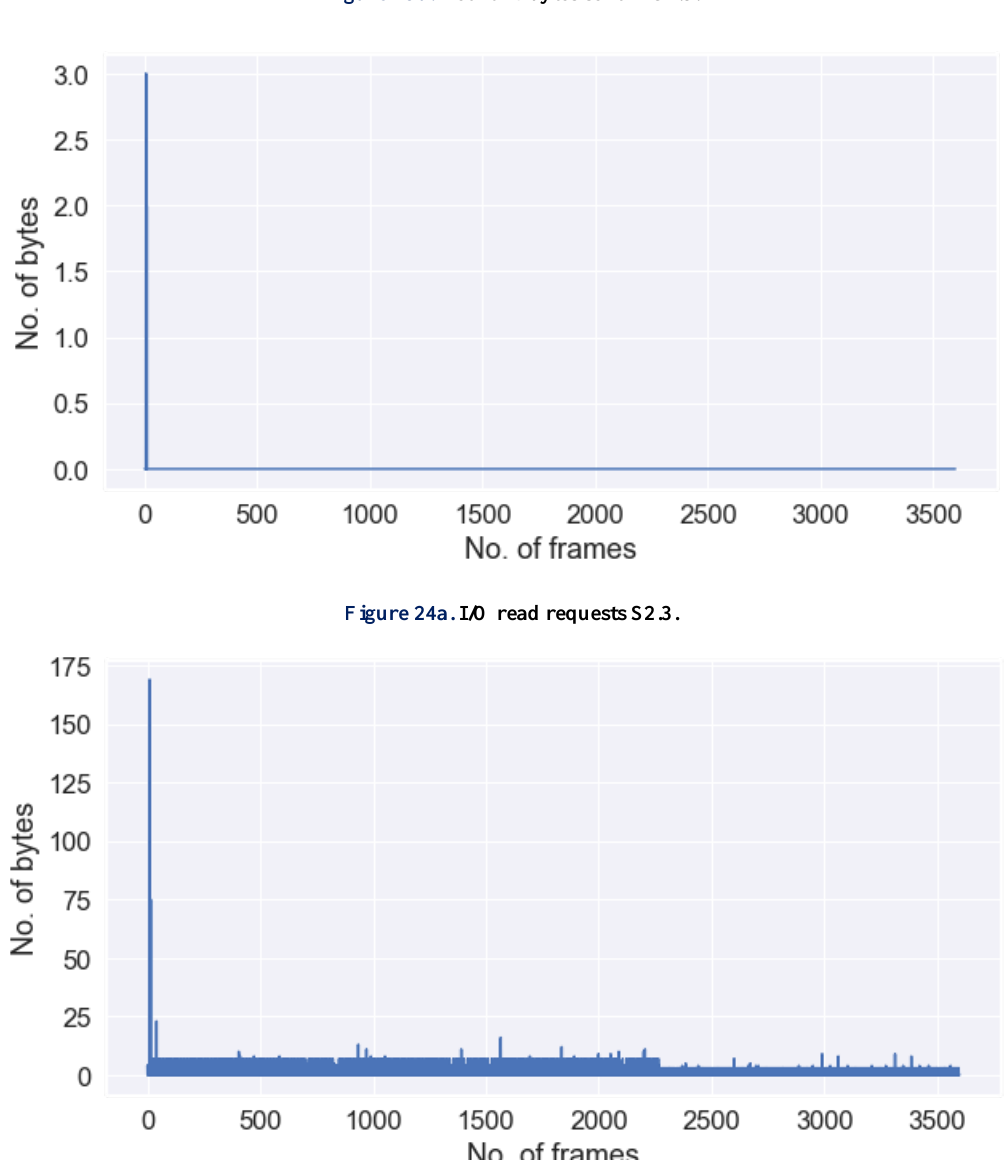
Figure 23b. Network bytes sent in S2.3.